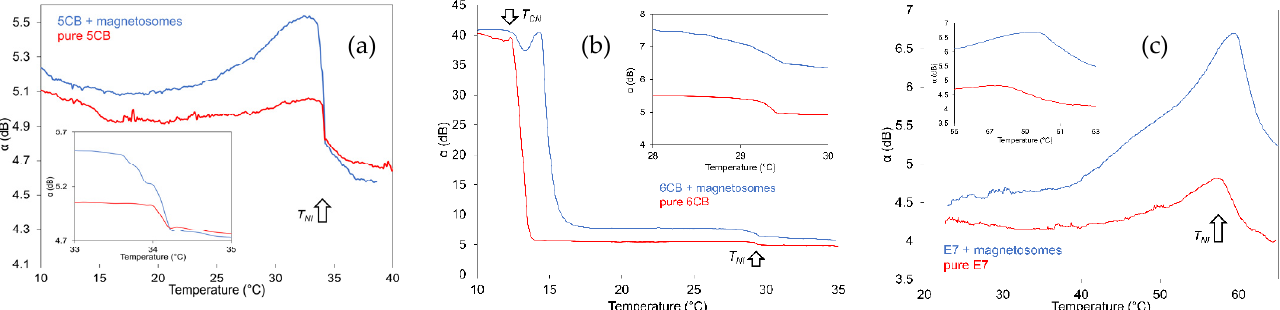
Figure 5. Comparing of temperature dependences of SAW attenuation measured for 5CB ( a ) 6CB ( b ) and E7 ( c ) doped with magnetosomes of concentrations 0.2 wt% with that of corresponding pure LCs.